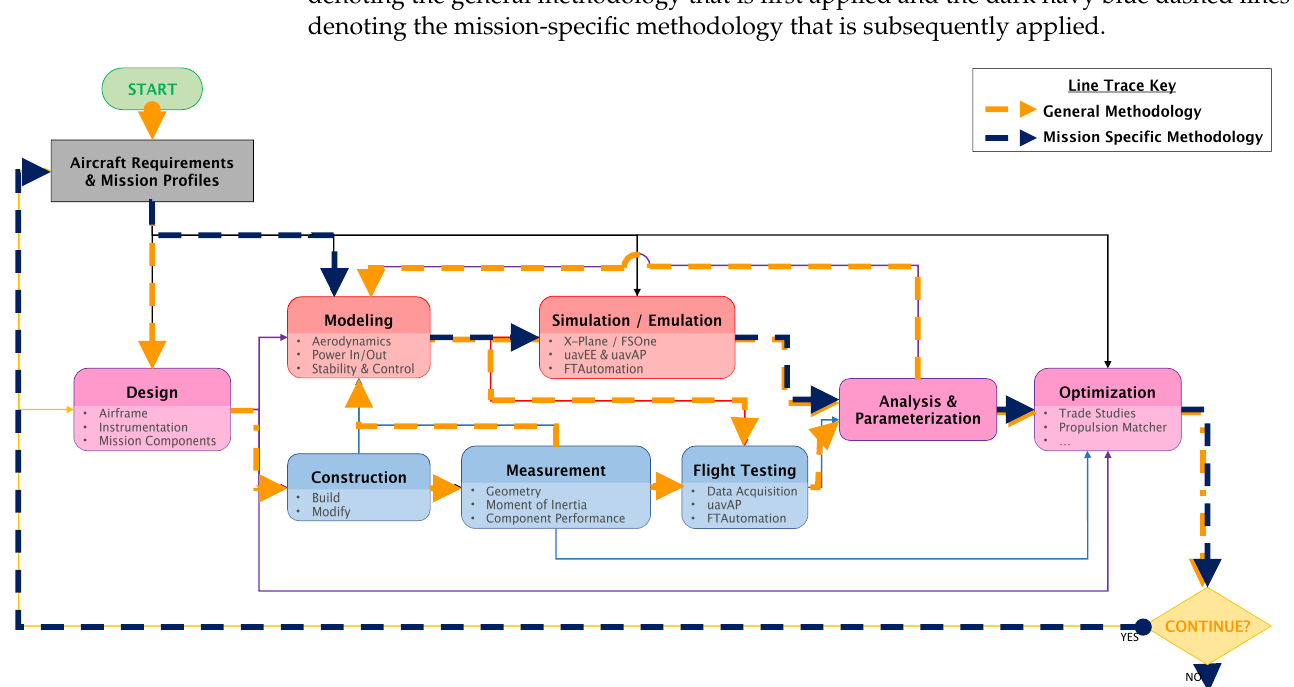
Figure 17. The UAV Development Framework used to quickly develop an aircraft for agricultural field